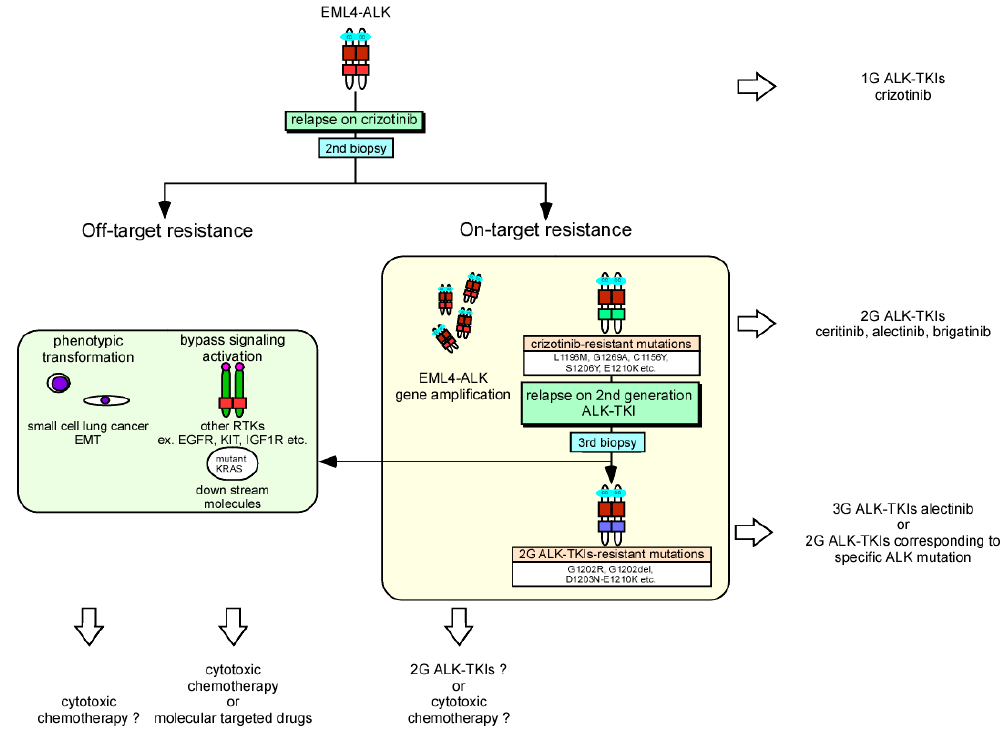
Figure 2. Forecast map of the treatment sequence for ALK-positive NSCLC.